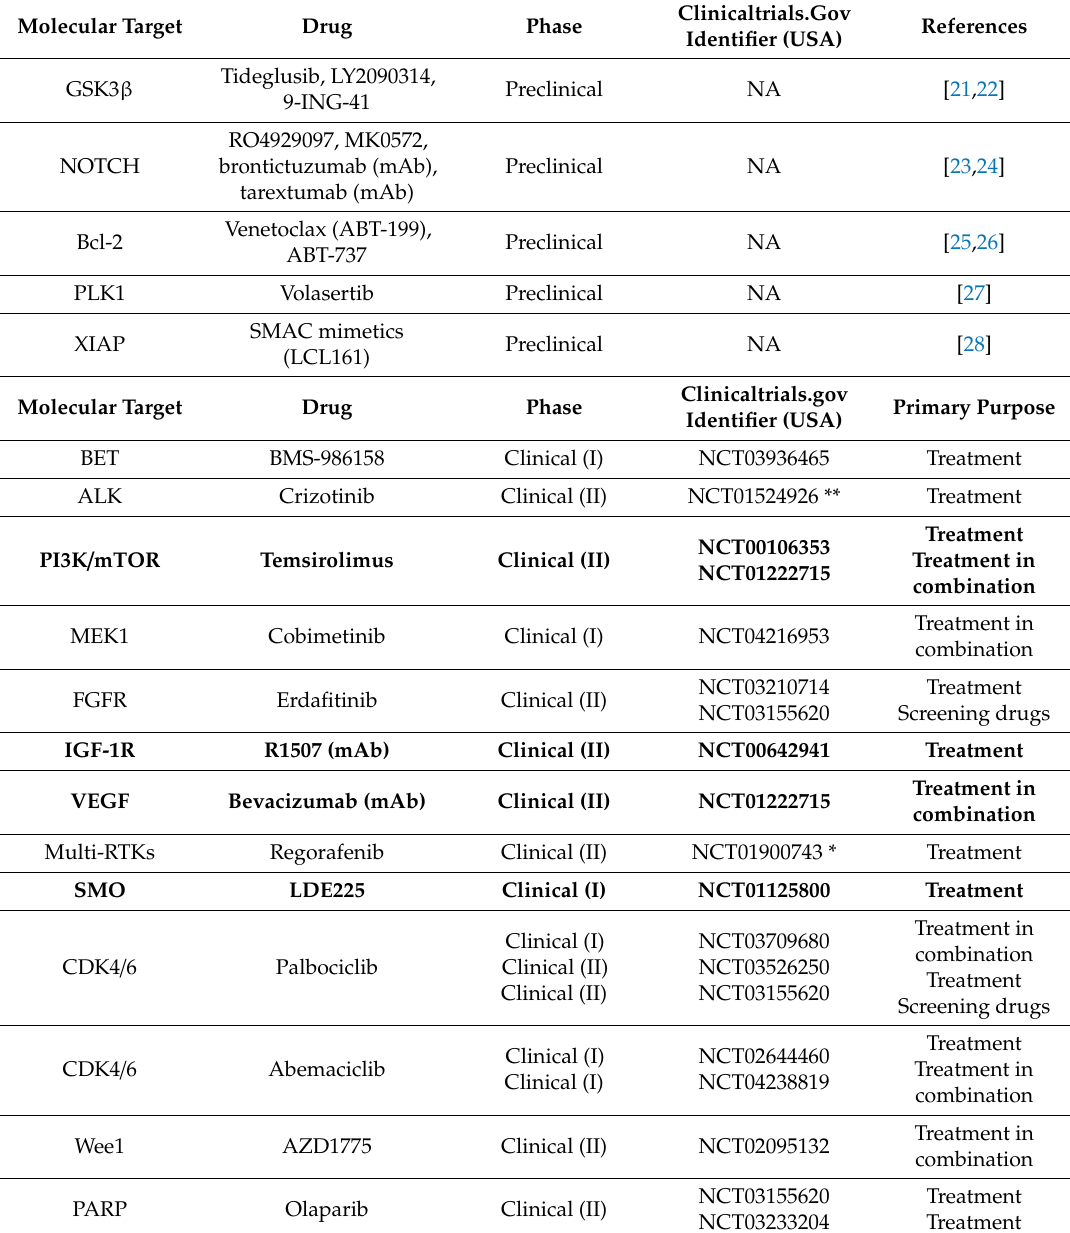
Table 1. Preclinical and clinical trials with targeted therapy in rhabdomyosarcoma